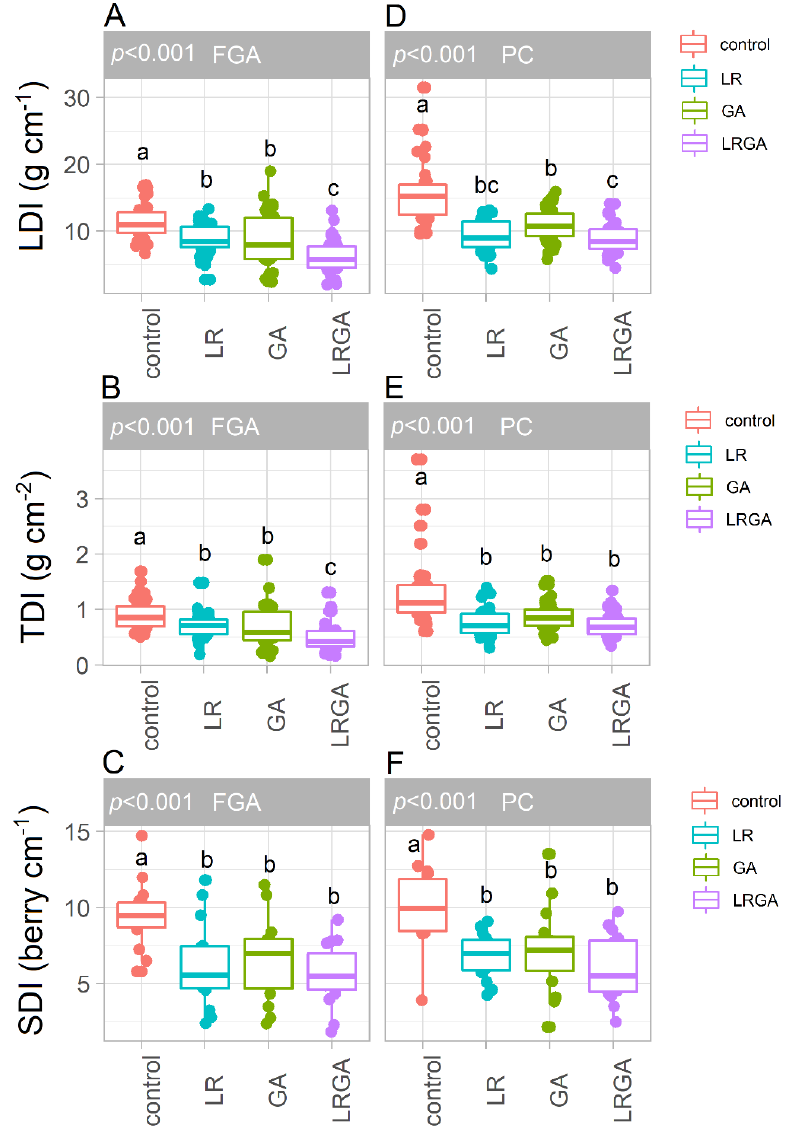
Figure 4. Ratio between bunch weight (g) and bunch length (cm) (LDI, ( A , D )), between bunch weight (g) and the exponentiation of bunch length (cm) (TDI, ( B , E )) and between the number of berries per bunch and bunch length (cm) (SDI, ( C , F )) assessed either in FGA and PC vineyard and in control, leaf removal (LR), GA 3 application (GA) and leaf removal plus GA 3 application (LRGA) plants (n = 15). In graphs, points represent raw data, horizontal lines within boxes indicate the median and boxes indicate the upper (75%) and lower (25%) quartiles. Whiskers indicate the ranges of the minimum and maximum values. Data were analyzed with one-way ANOVA with treatments as factor and p -value is shown in the graph. Different letters represent significant differences between treatments according to Tukey ’ s test.